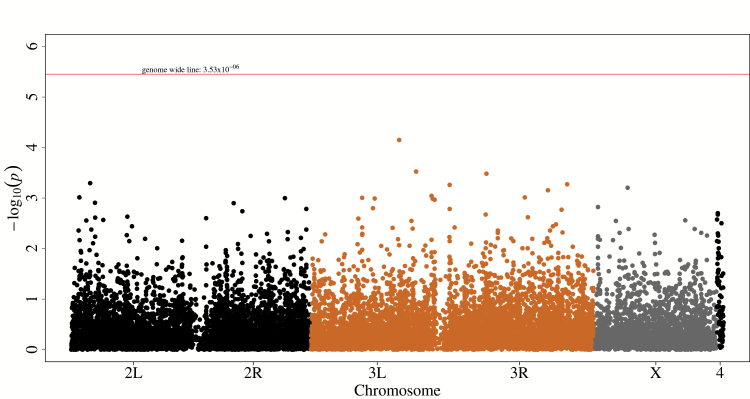
Manhattan plot for gene-based GWAS. Each point represents a gene. The height of the gene represents the strength of association with lifespan, expressed as −log10(p value). The red horizontal line represents genome-wide Bonferroni significance threshold (p = 3.53×10−06).